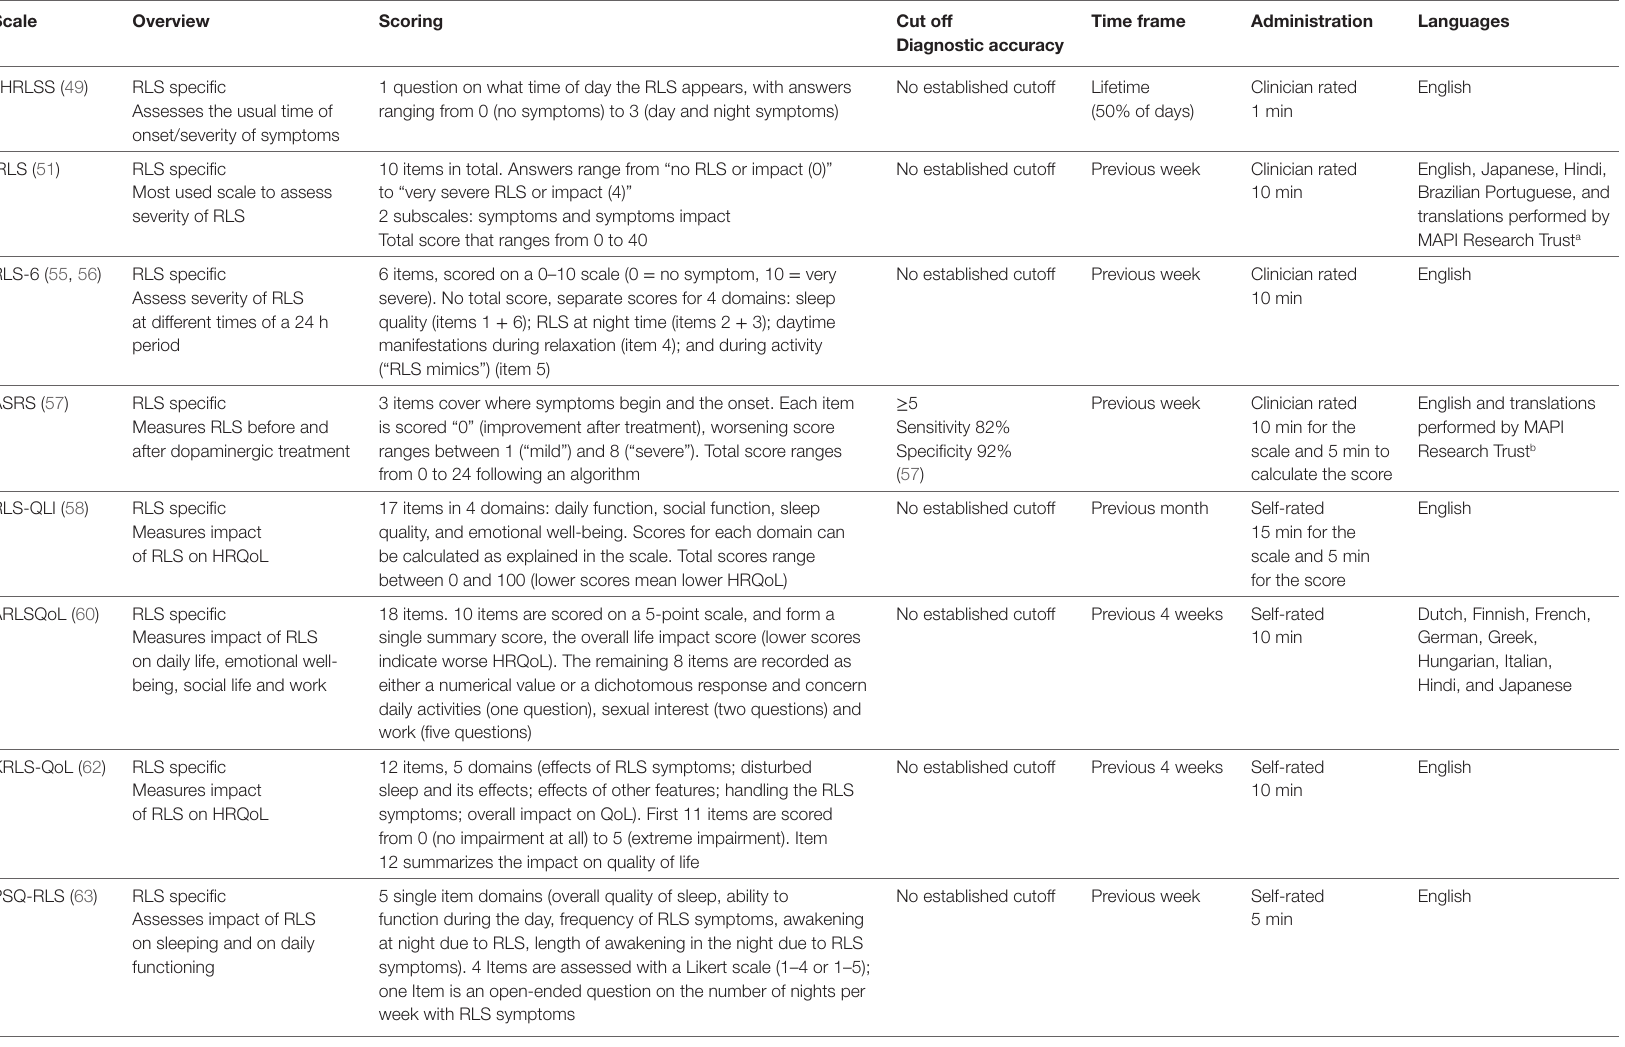
TABLe 2 | Scales that evaluate restless legs